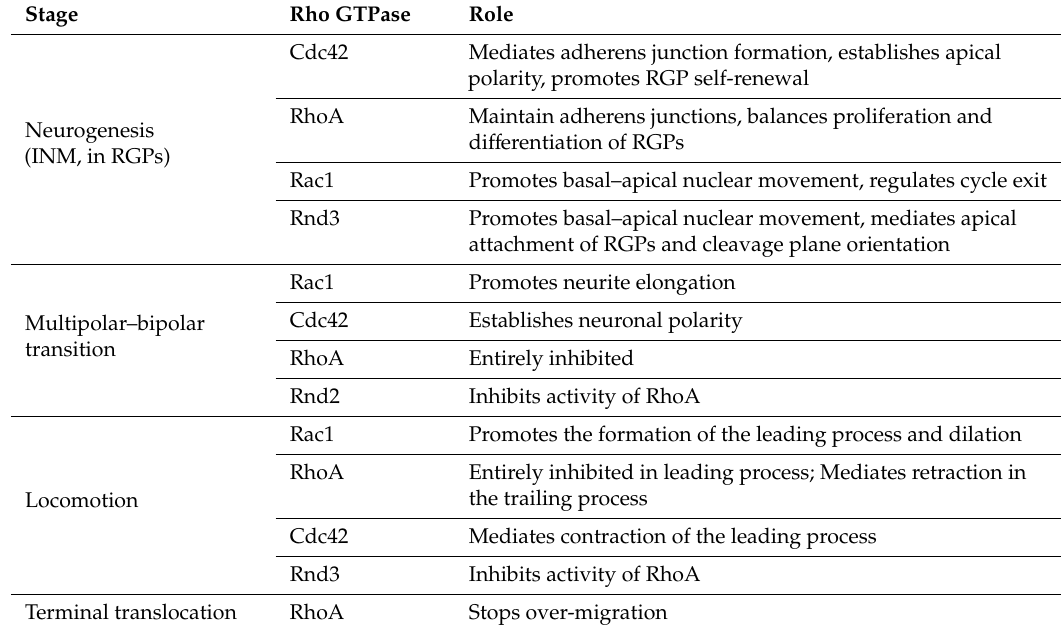
Table 1. Rho GTPases regulate di ff erent processes during neuronal